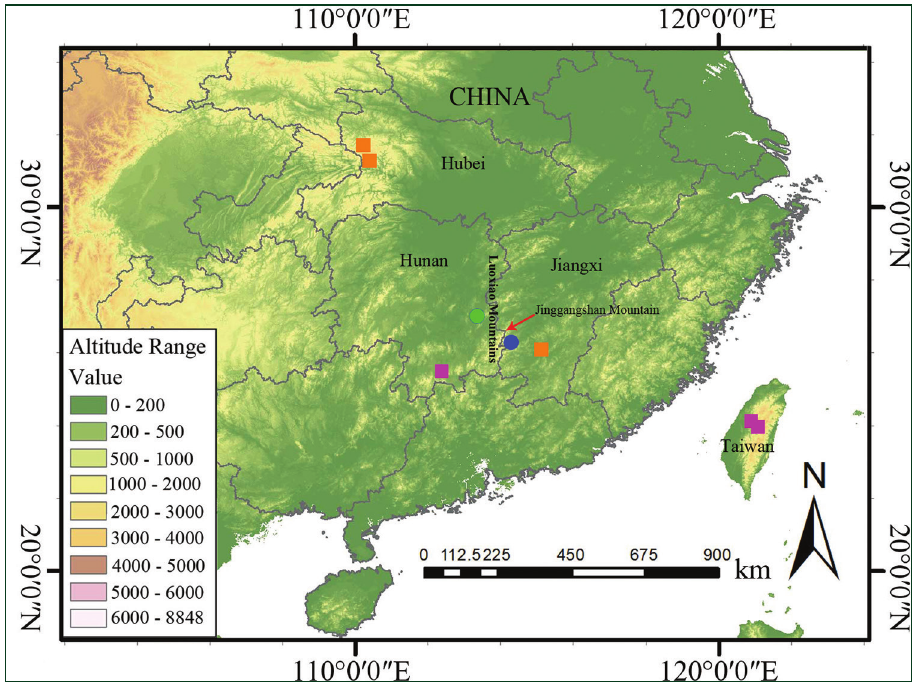
Figure 3. Distribution map of Calanthe sieboldopsis (blue and green circles show the type locality and another occurrence, respectively) and C. sieboldii (purple and orange squares show historical records and the recently-discovered localities,